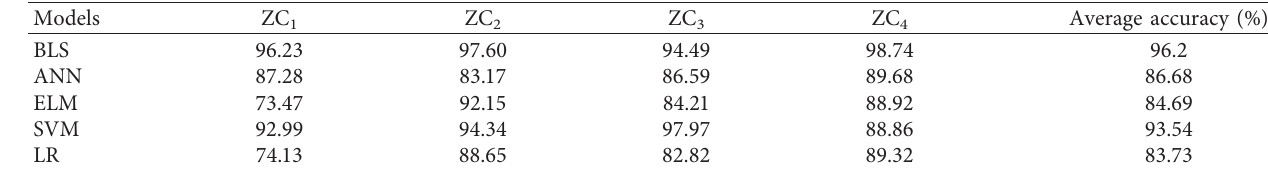
Table 4: Comparison of classification